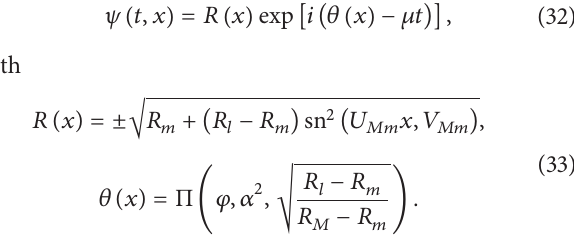
(2) Recall that ℎ 2 = 𝐻(±𝑅 2 , 0) with the equilibriums (𝑅 , 0) , 𝐸 (−𝑅 , 0) , where the function 𝐻(𝑅, 𝑆) is defined 𝐸 2 2 3 2 by (8). For each ℎ ∈ (ℎ 2 , ℎ 1 ) , 𝐻(𝑅, 𝑆) = ℎ defines two families of periodic orbits of system (7) enclosing the center (𝑅 2 , 0) or (−𝑅 2 , 0) , which lie on both sides of the straight line 𝑅 = 0